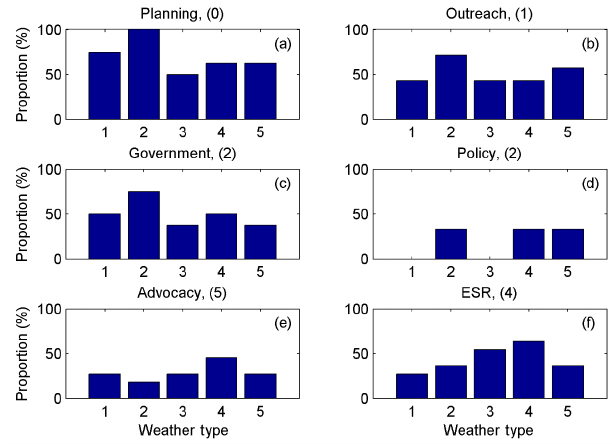
Figure 5. Reported flooding mechanisms that contribute to local flooding: 1 – extratropical system, 2 – local convective rainfall, 3 – tropical moisture derived rainfall, 4 – snowmelt events, 5 – release of ice jam. Values in parentheses indicate the number of respondents who did not offer an answer. Table 3. Perceptions of future riverine flooding risk within Tomp- kins County by flooding practitioners. Not Less Same More sure risk risk